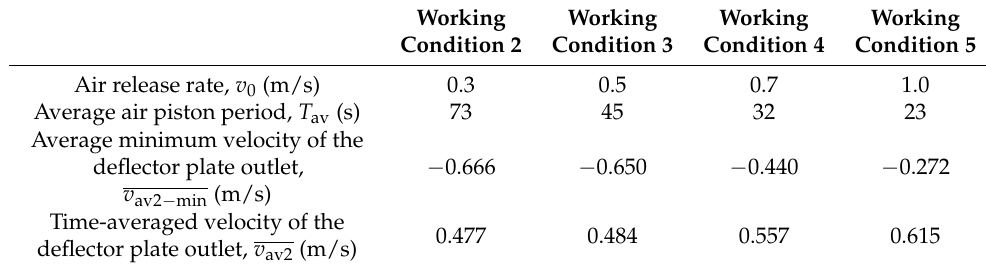
Table 4. Computational results of the oxygenation performance with different air release rates.